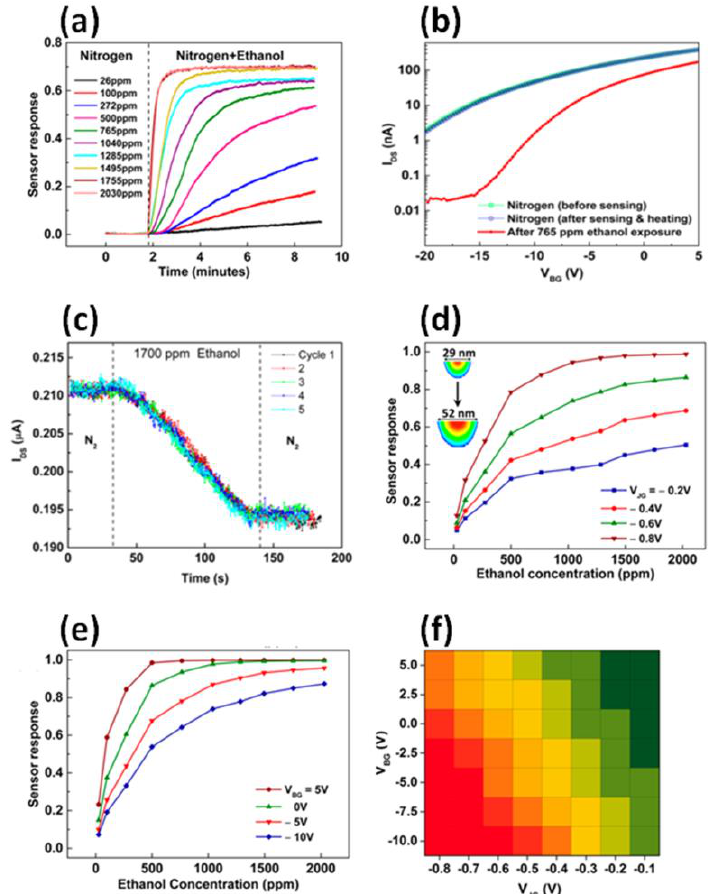
Figure 4. Ethanol sensing with an EFN gas sensor. ( a ) Sensor response vs time for various ethanol concentrations; ( b ) EFN gas sensor recovery using ex situ heating; ( c ) reproducibility measurements of the EFN gas sensor; ( d ) sensor response for various ethanol concentrations at various V JG values; ( e ) sensor response to various ethanol concentrations at various V BG values; ( f ) color map of the sensor response of the EFN gas sensor under different biasing conditions. Reprinted with permission from [35]. Copyright 2016 American Chemical Society.